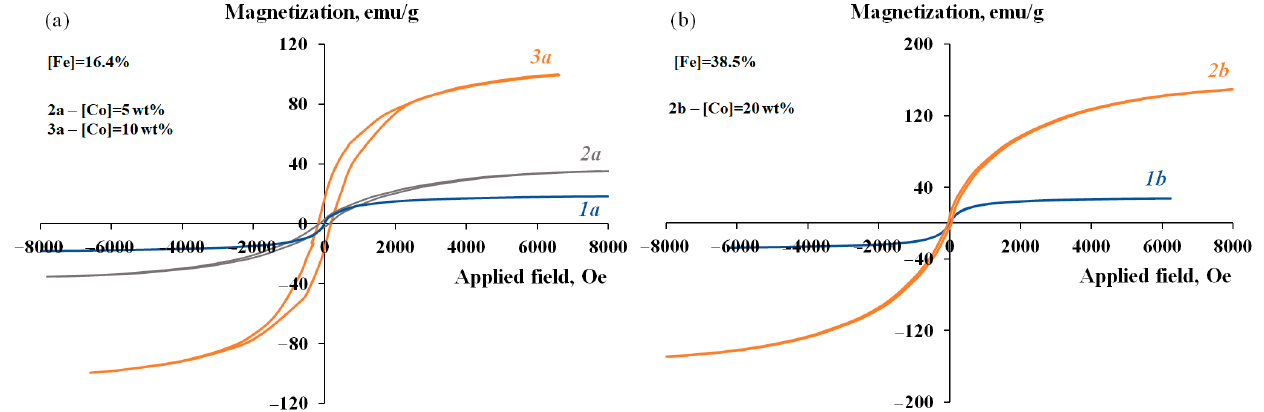
Figure 13. Magnetization of Fe 3 O 4 /P ‐ N ‐ PAA ( 1a , 1b ) and MNP/P ‐ N ‐ PAA, obtained at 800 °C, [Co] = 5 ( 2a ), 10 ( 3a ) and 20 wt% ( 2b ), as a function of applied magnetic field.